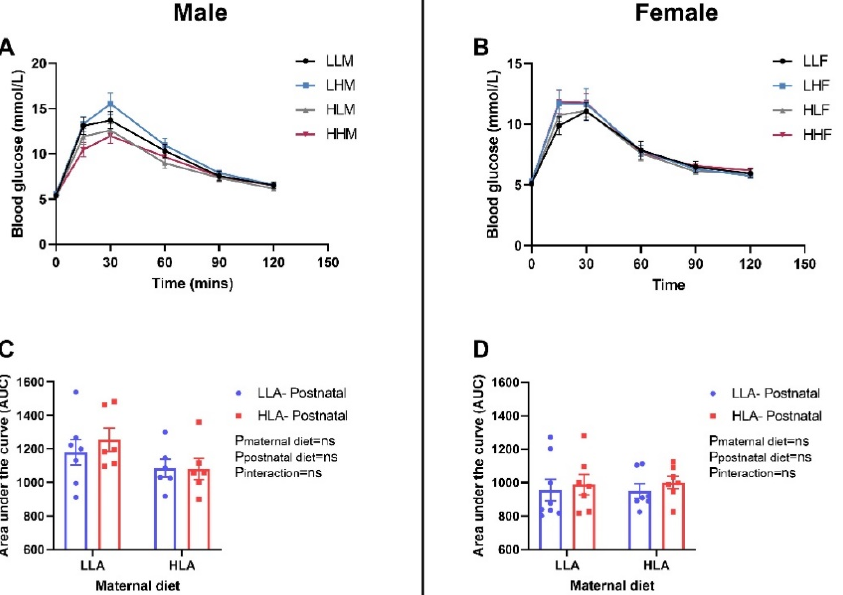
Figure 3. Effect of a maternal and postnatal diet high in linoleic acid on glucose tolerance in adult offspring. Data are presented as mean ± standard error of the mean (SEM). The area under the curve (AUC) was calculated using GraphPad Prism. Two-way ANOVA was performed for statistical analysis with maternal diet and postnatal diet as two factors. n = 6–8. LLA: low linoleic acid; HLA: high linoleic acid; PN: postnatal; GTT: glucose tolerance test. A : Blood glucose male; B : Blood glucose female; C : Area under the curve male; D : Area under the curve female.